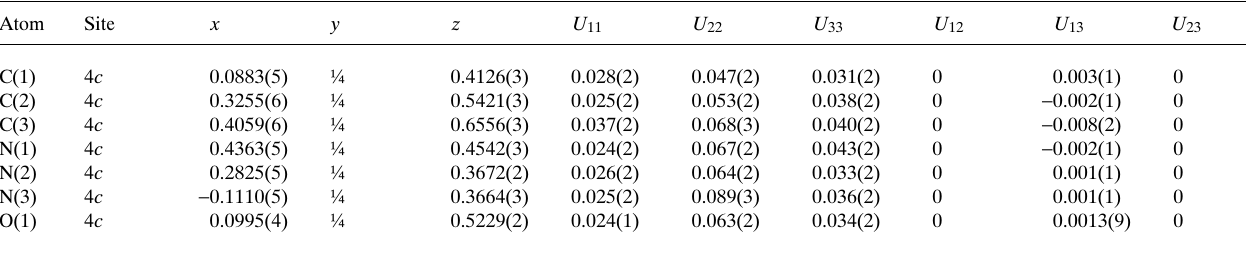
Table 3. Atomic coordinates and displacement parameters (in Å 2 )